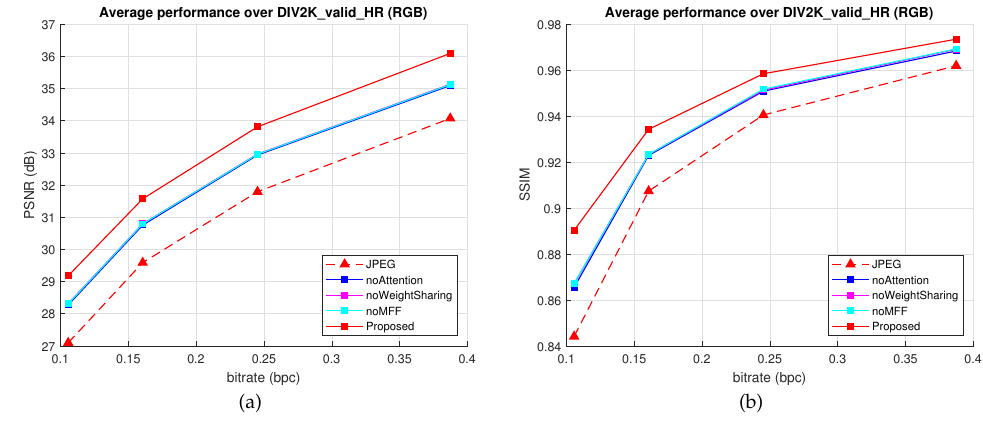
Figure 13. Ablation study of the ASQE-CNN architecture. Average performance over the